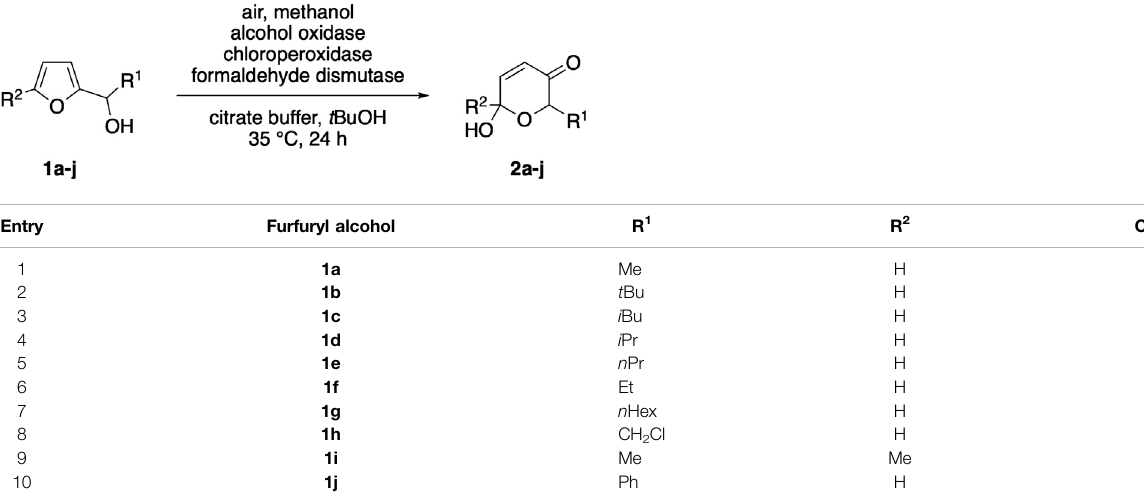
TABLE 2 | Substrate scope of the triple-enzymatic Achmatowicz oxidation.